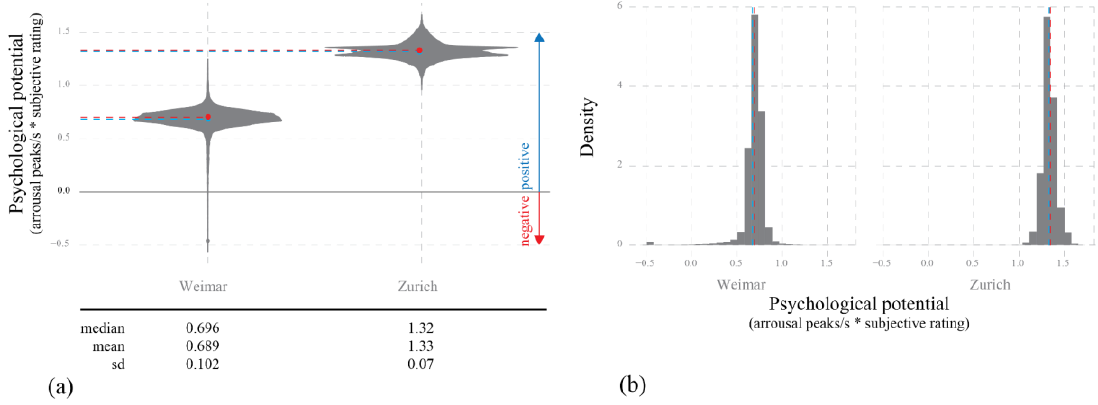
Figure 11. Distribution of the Psychological potential (predicted arousal peaks/s combined with psychological subjective ratings) across the two case studies. Score above zero stand for positive arousal and scores below zero stand for negative arousal. ( a ) violin plot, with highlighted median (red) and mean (blue) values ( b ) histogram with highlighted median (red) and mean (blue).